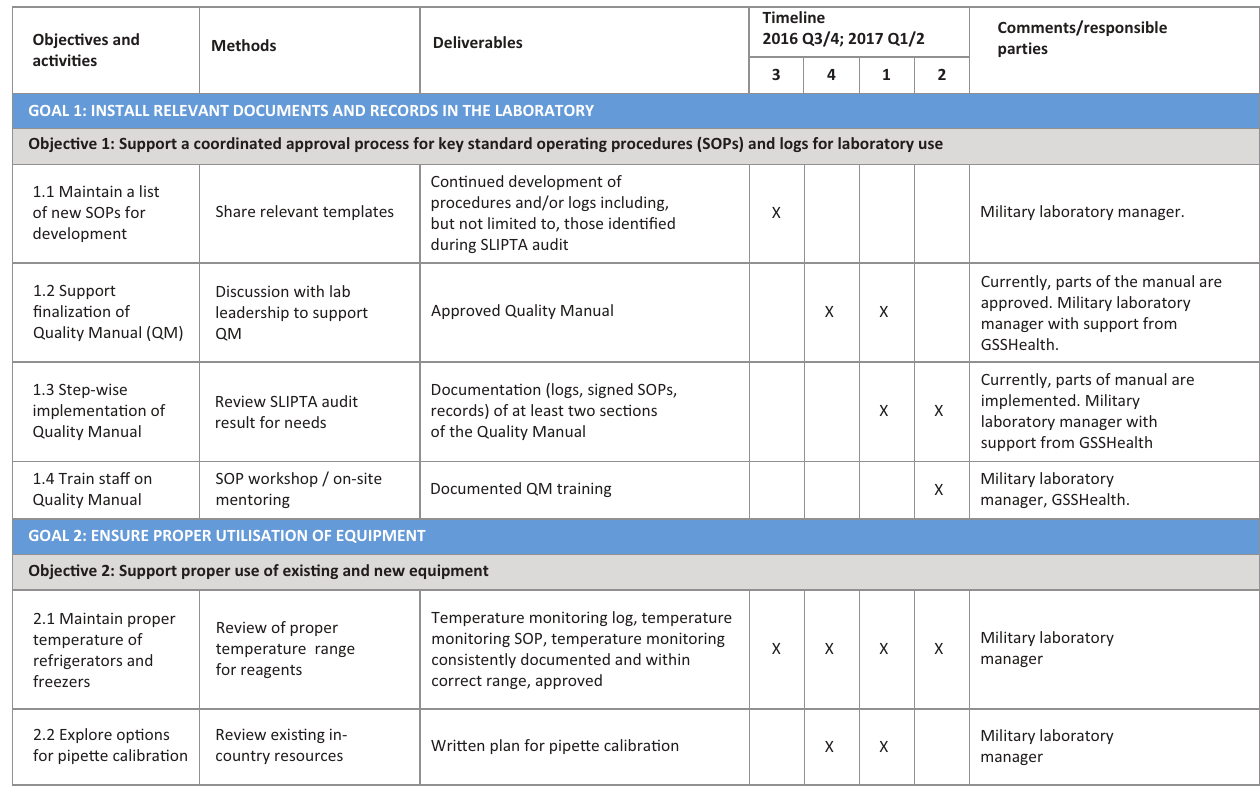
FIGURE 1: Example of a quality improvement work plan (first page) developed by the Army Teaching Hospital – University Teaching Hospital laboratory, Benin, 2016–2017.